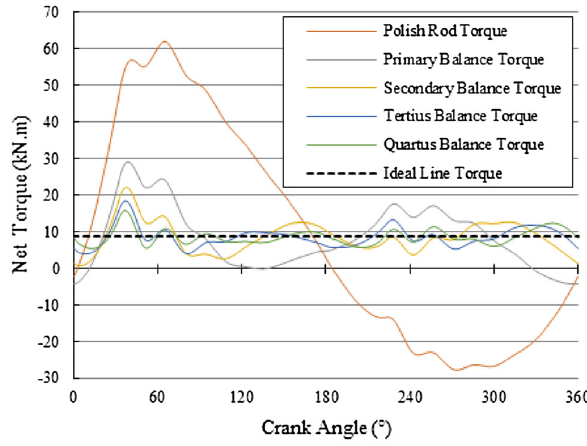
Fig. 11 Multi-balance to polished rod torque (Feng et al. 2015)